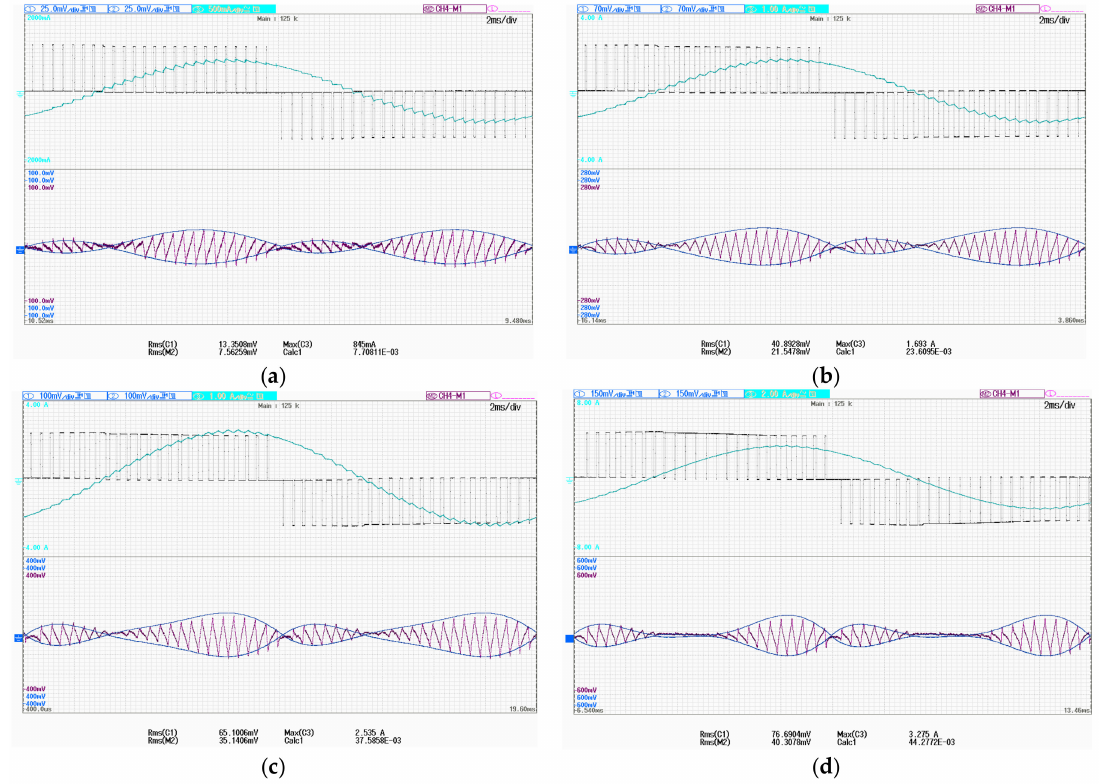
Figure 14. Experimental results for ϕ = 60 ◦ : upper half, output voltage and current; lower half, analytically calculated envelope and measured DC voltage switching ripple. ( a ) m = 0.25; ( b ) m = 0.50; ( c ) m = 0.75; ( d ) m =